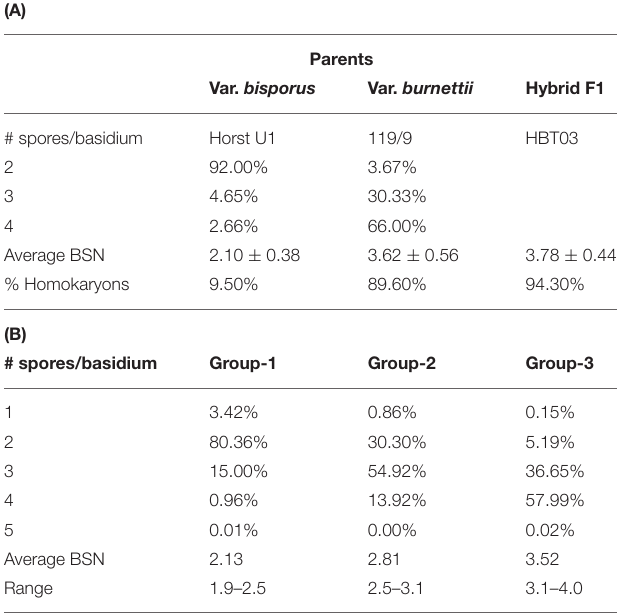
TABLE 1 | Phenotypic data of basidial spore number (BSN) for parents, the intervarietal hybrid (A) and the intercross (B)